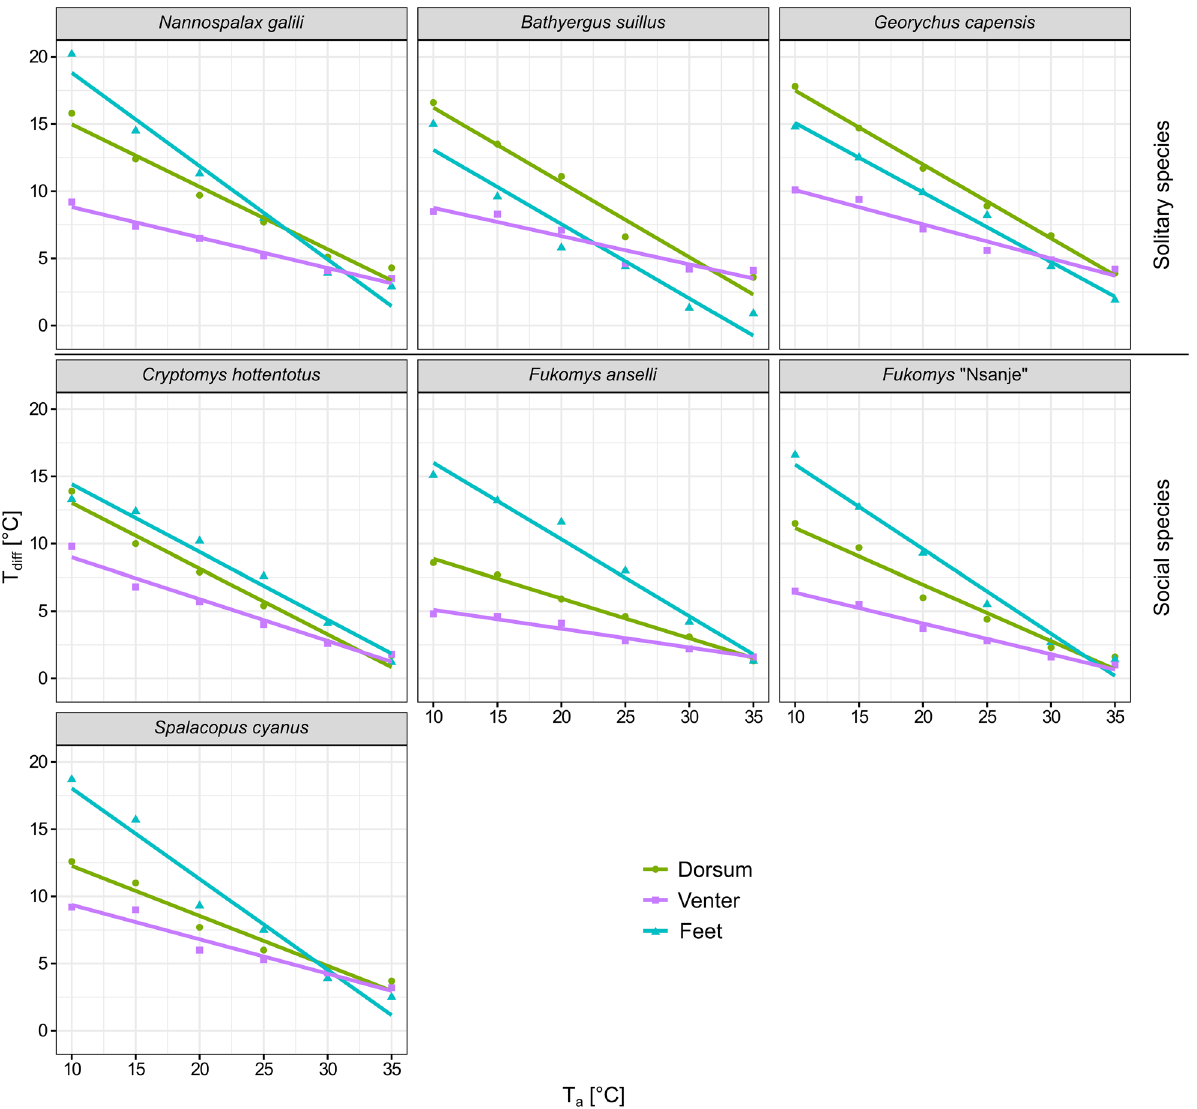
Figure 3. The difference between core body temperature and surface temperature (T diff ) for the dorsum, the venter, and the feet across the range of ambient temperature (T a ) in seven subterranean rodent species. Points indicate mean values, straight lines are the regression lines predicted by linear models. The figure was prepared using the program Inkscape 0.92 (https ://inksc